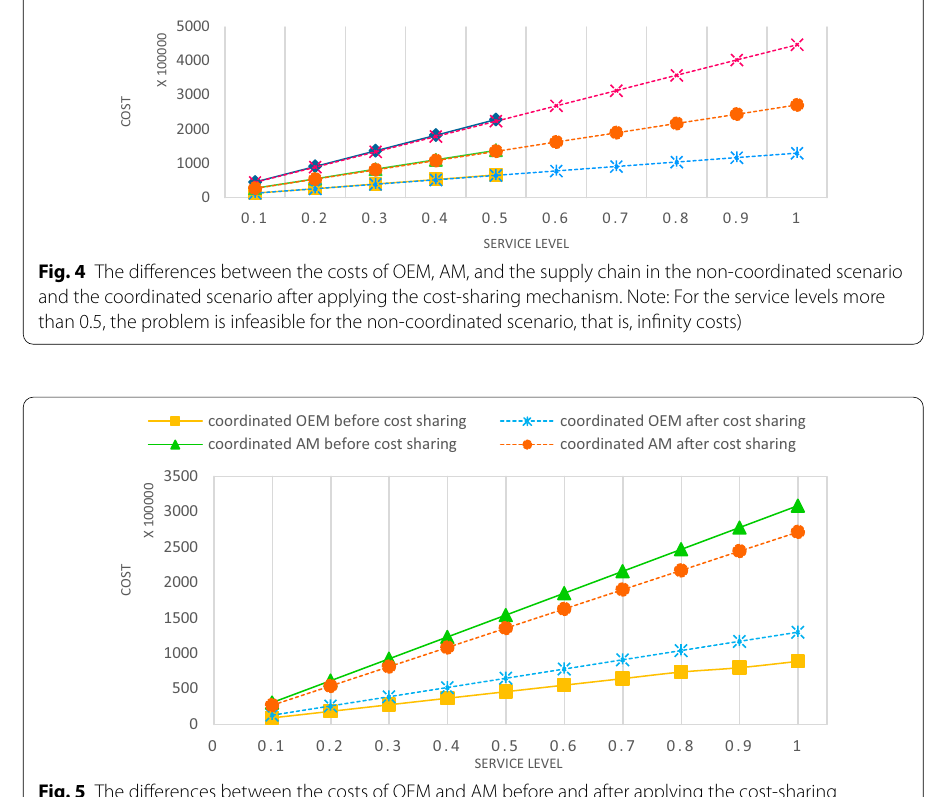
Fig. 5 The differences between the costs of OEM and AM before and after applying the cost-sharing mechanism in the coordinated